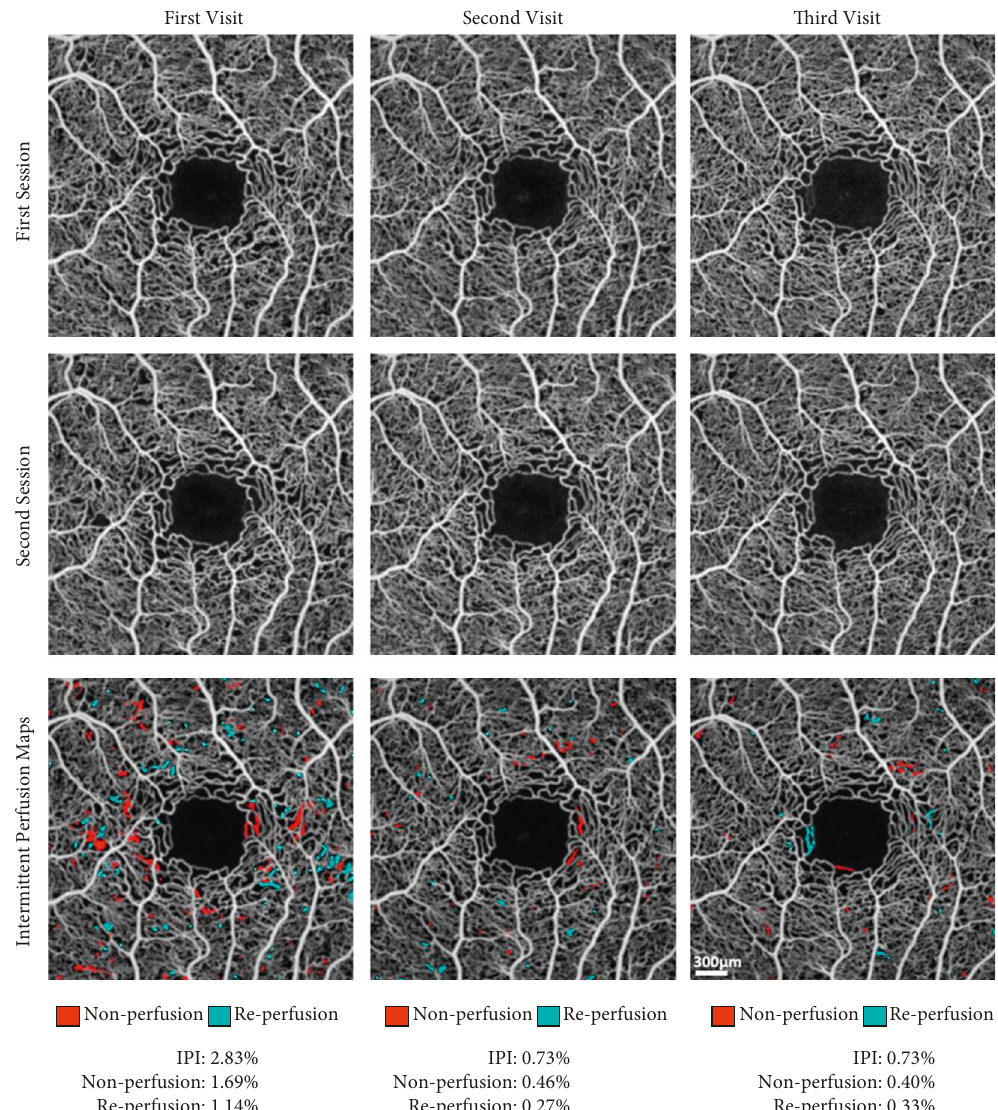
Figure 1: OCT-A images of the left eye of the HbSS patient, imaged across 3 imaging visits. The left column shows averaged OCT-A images from the first visit, the middle column from the second visit, and the right column from the third visit. The first and second rows show the averaged OCT-A images from the first and second sessions, respectively, taken 1 hour apart during each visit. The third row of images represents the computed intermittent perfusion maps. Nonperfusion between sessions is highlighted in red, and reperfusion between sessions is highlighted in cyan. The sum of the nonperfusion and reperfusion percent densities equals the intermittent perfusion index